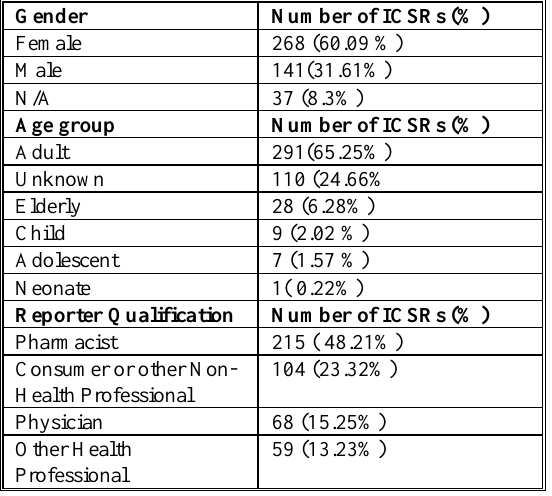
Table 5. ADRs classification based on the SOC